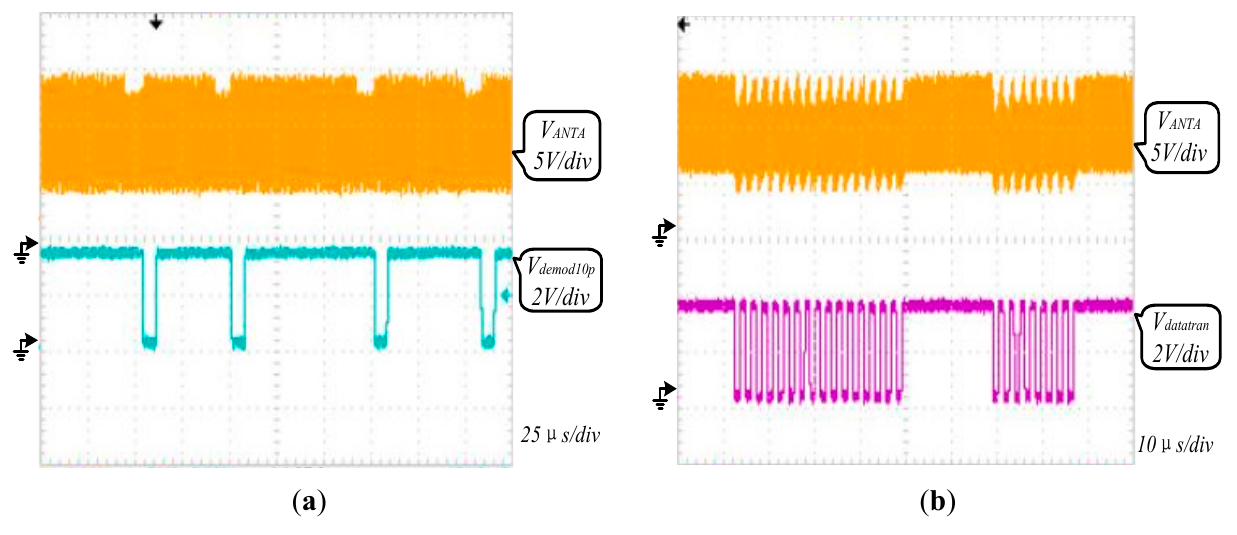
Figure 12. ( a ) Waveform of demodulation; ( b ) Waveform of modulation.